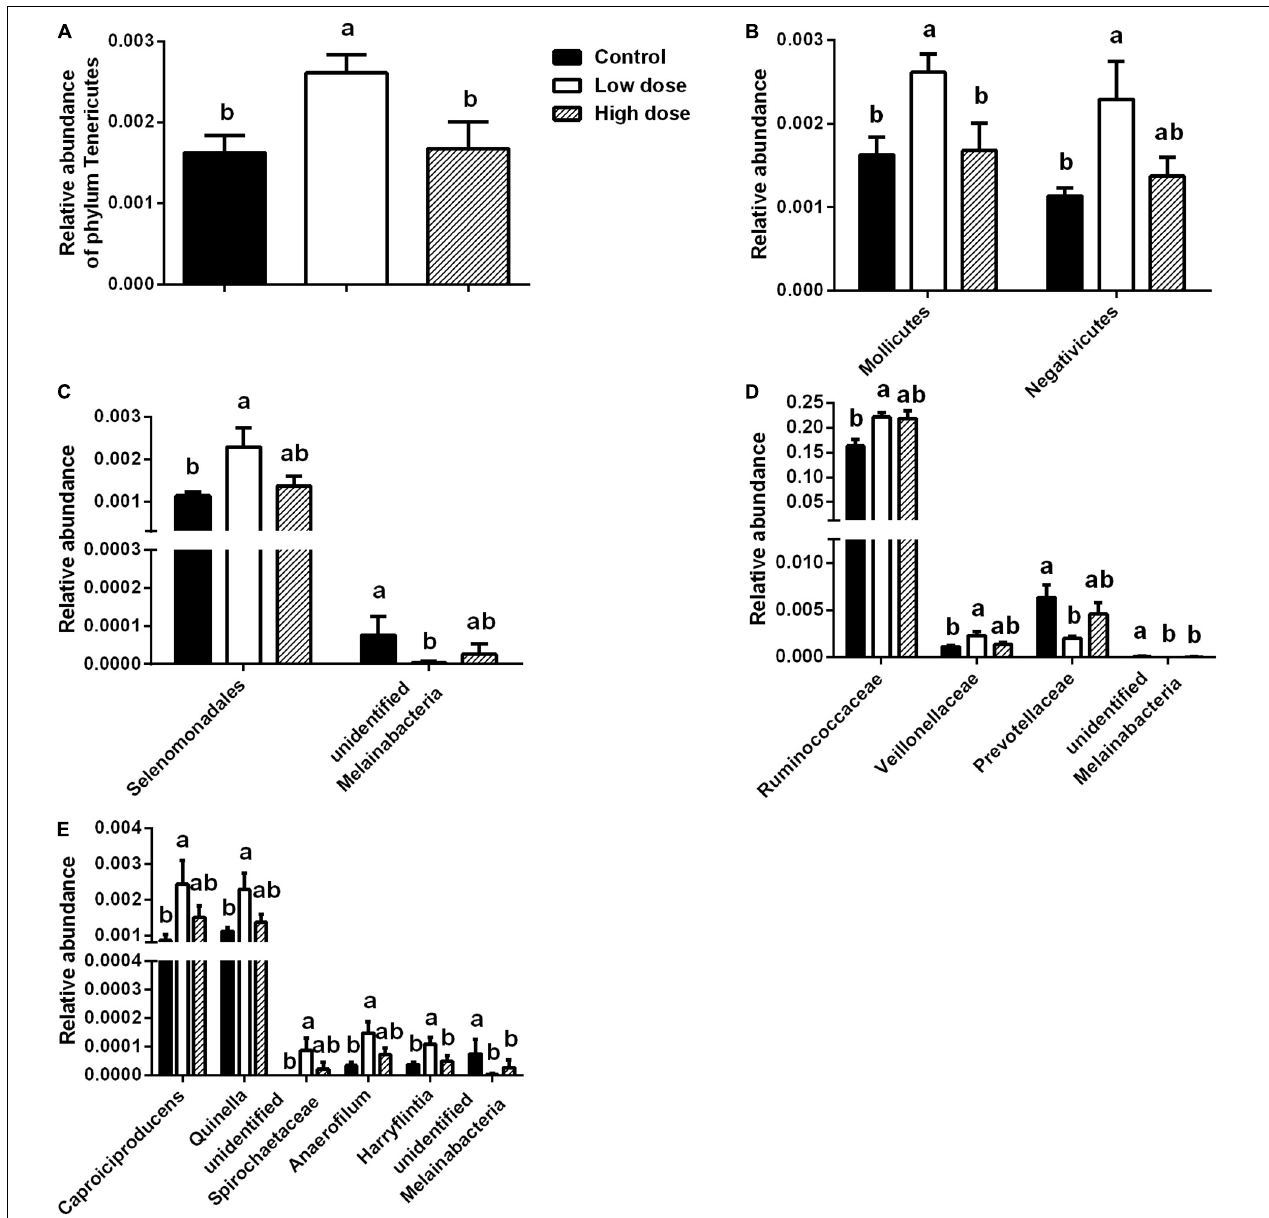
FIGURE 5 | Differences in taxa abundances of cecal microbiota at different taxonomic levels among control group (0 mg/kg 6-MBOA), low 6-MBOA dose group (1 mg/kg 6-MBOA) and high 6-MBOA dose group (2 mg/kg 6-MBOA) in adult male Brandt’s vole. (A) Phylum level; (B) class level; (C) order level; (D) family level; (E) genus level. Error bars indicate standard errors. Same letters connect bars with no significant differences at P < 0.05 ( n =